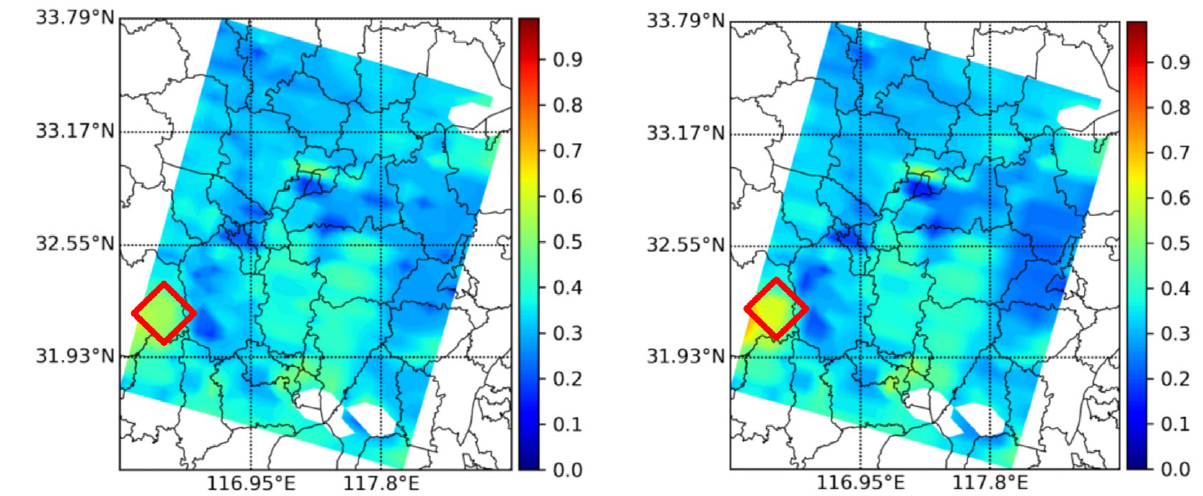
Figure 8. POSP AOD inversion results ( a ) vs. MODIS products ( b ) (4 May 2022).